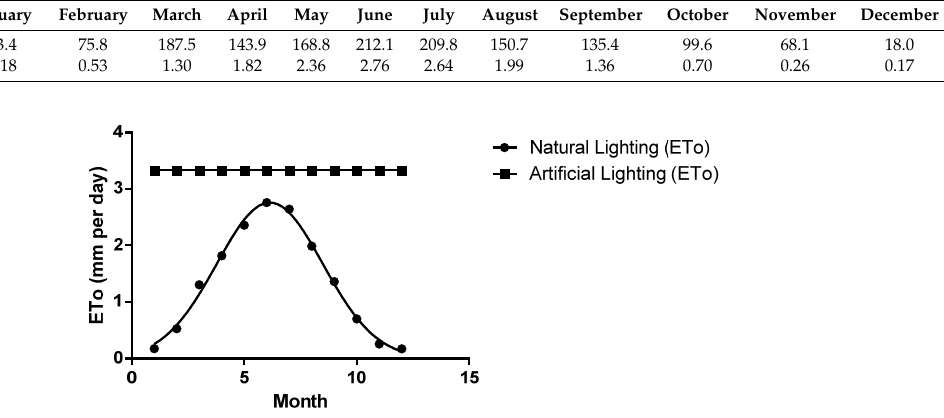
Table 2. Optimal growth parameters for tilapia. Parameter Threshold for Optimal Growth